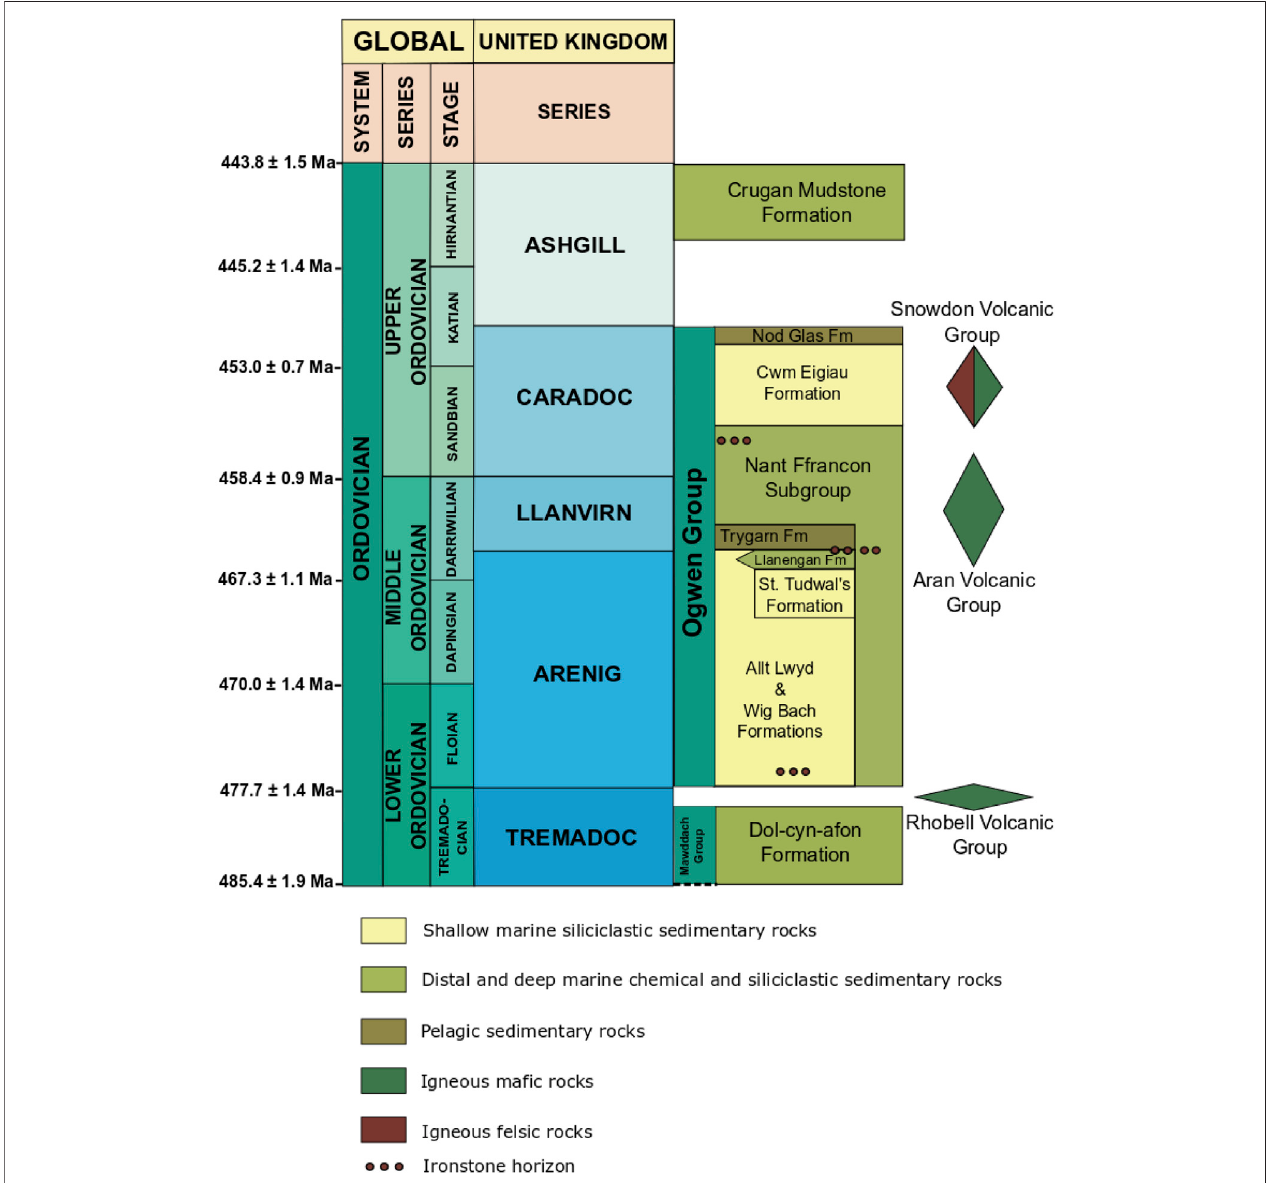
FIGURE3| GeneralstratigraphyofOrdoviciansedimentaryrocks,NorthWales(modi fi edfromRushtonandFortey,2000).OnlytheironstoneoftheArenig/Llanvirn boundary was investigated in this study. Global (Cohen et al., 2019) and local series names (Cooper et al., 2012) are shown for comparison.